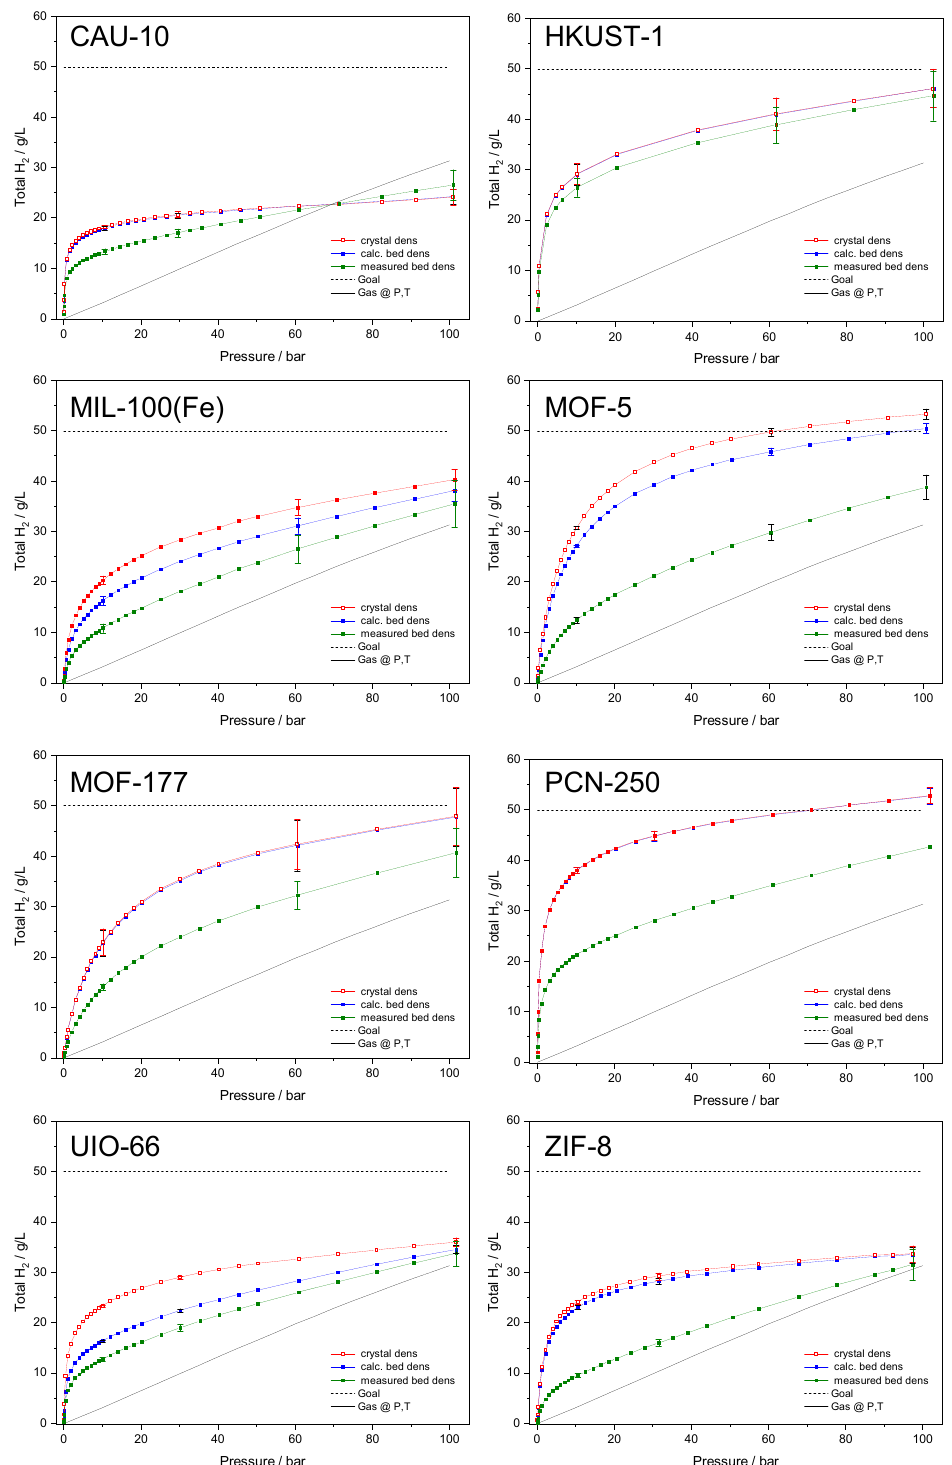
Figure 6. Volumetric total hydrogen adsorption isotherms for MOFs at 77 K. Comparison of storage density calculated from measured crystal density, calculated bed density, and measured bed density.